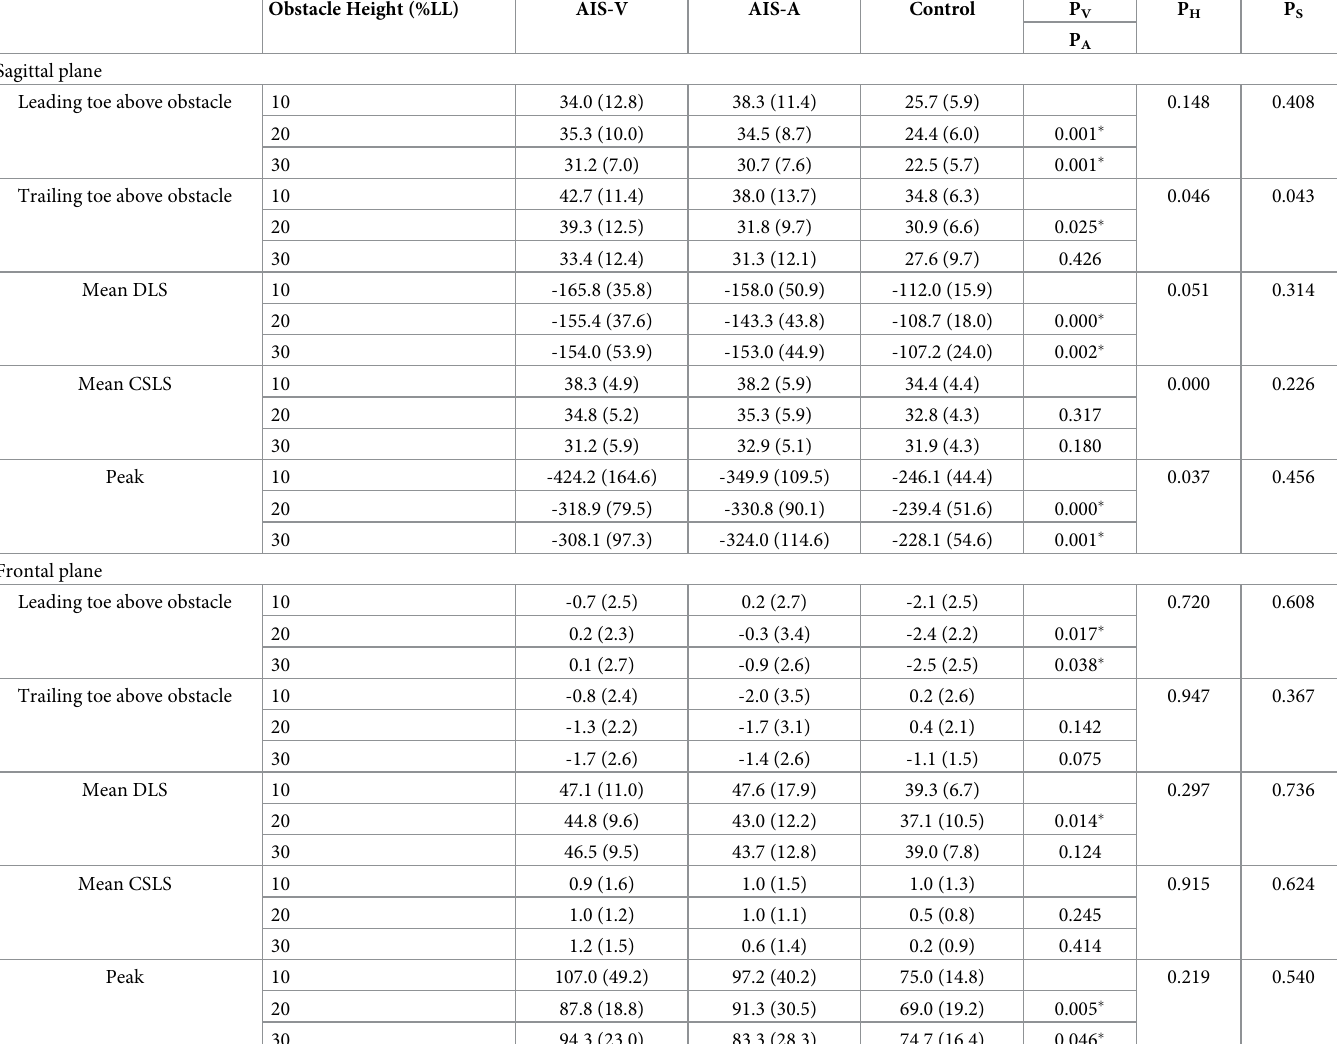
Table 3. Means (standard deviations, SD) of the sagittal and frontal rates of change of COM-COP inclination angles (˚/s) in the patients with adolescent idiopathic scoliosis and healthy controls when crossing obstacles of heights of 10%, 20% and 30% of subjects’ leg